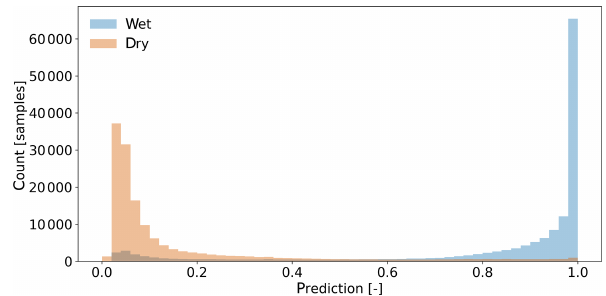
Figure 5. Raw CNN predictions on VALAPRB, colored according to the reference.